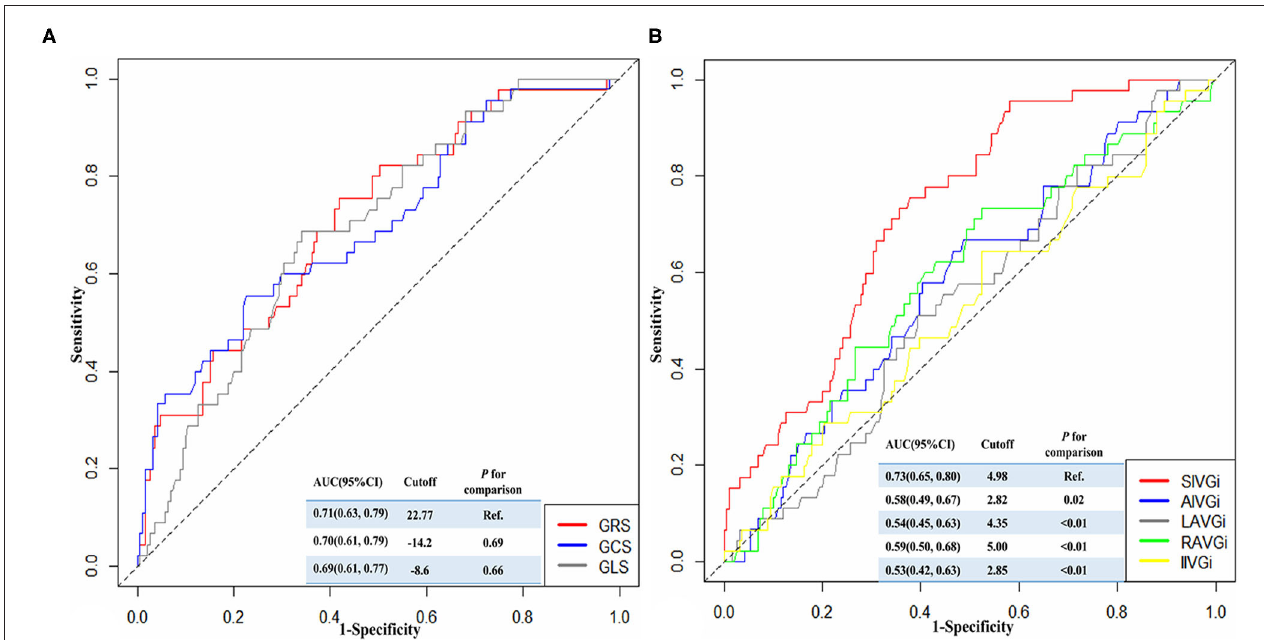
FIGURE 1 | The time-dependent receiver operator characteristic (ROC) curves showing the discriminative ability of different strain characteristics (A) and PCAT thickness characteristics (B) for predicting 1-year major adverse cardiac events (MACE). AIVGi, Anterior interventricular groove PCAT thickness index; AUC, Areas under the ROC curve; CI, confidence interval; GCS, Global circumferential strain; GLS, Global longitudinal strain; GRS, Global radial strain; IIVGi, Inferior interventricular groove PCAT thickness index; LAVGi, Left atrioventricular groove PCAT thickness index; MACE, Major adverse cardiac events; PCAT, Pericoronary adipose tissue; RAVGi, Right atrioventricular groove PCAT thickness index; ROC, Receiver operator characteristic curve; SIVGi, Superior interventricular groove PCAT thickness